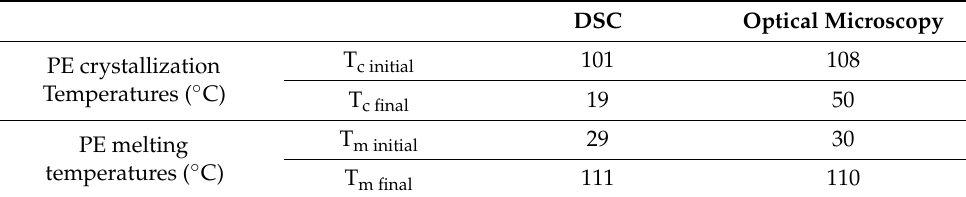
Table 3. Comparison of melting and crystallization temperatures of PE determined by optical microscopy and